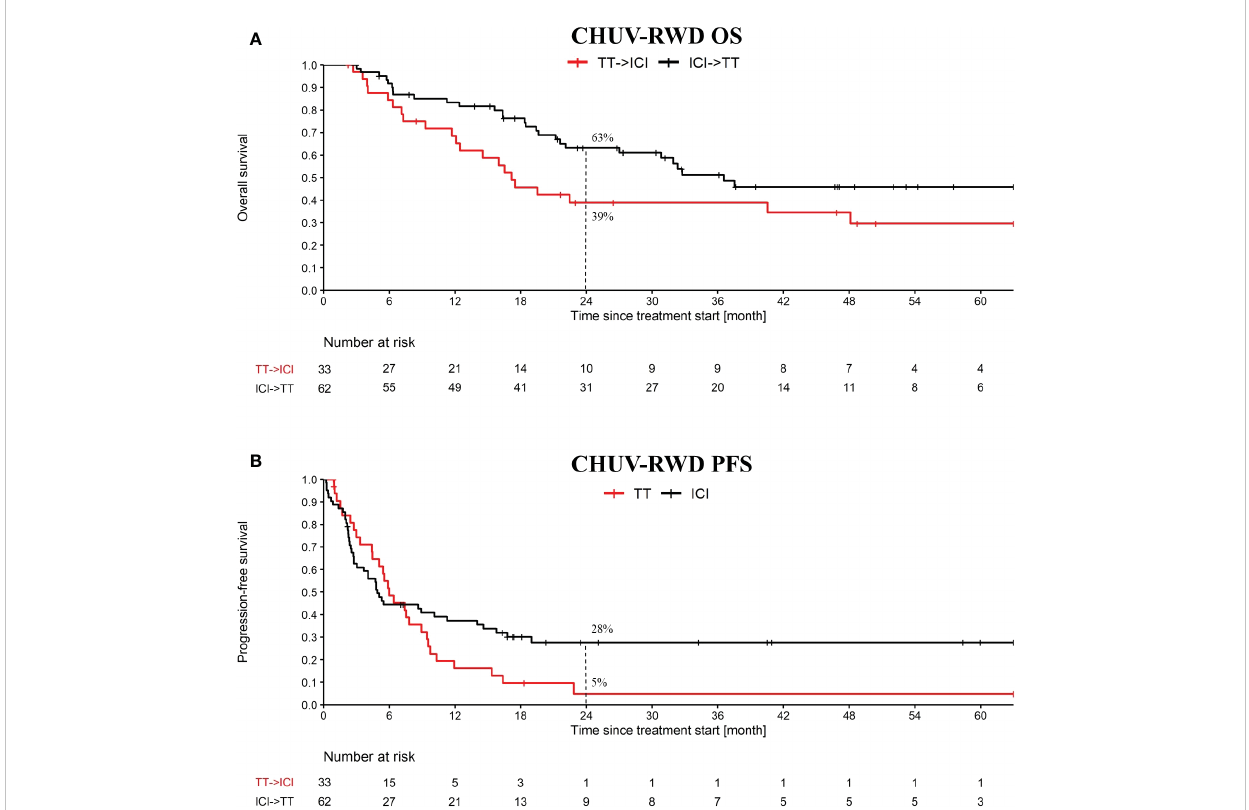
FIGURE 4 OS and PFS from the treatment sequence: targeted treatment (TT) followed by ICI and the converse. OS (A) and PFS (B) analysis starts at the fi rst cure of the fi rst treatment. The PFS analysis is only evaluating the fi rst treatment. TT refers to targeted therapy (i.e. BRAFi+/-MEKi) and ICI refers to PD1+/-CTLA4. Dashed lines at 24 month indicate the percent of patients left in each